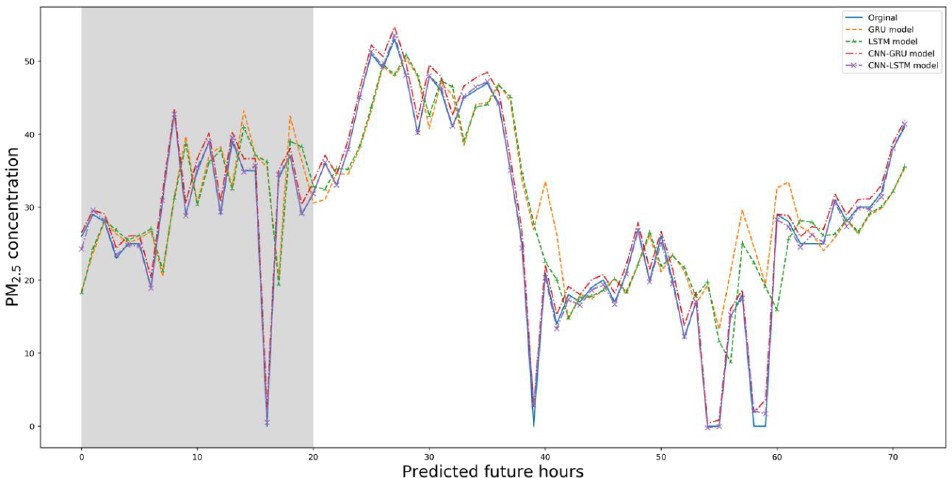
Figure 13. Predicted 3-day PM 2.5 concentrations; all models.